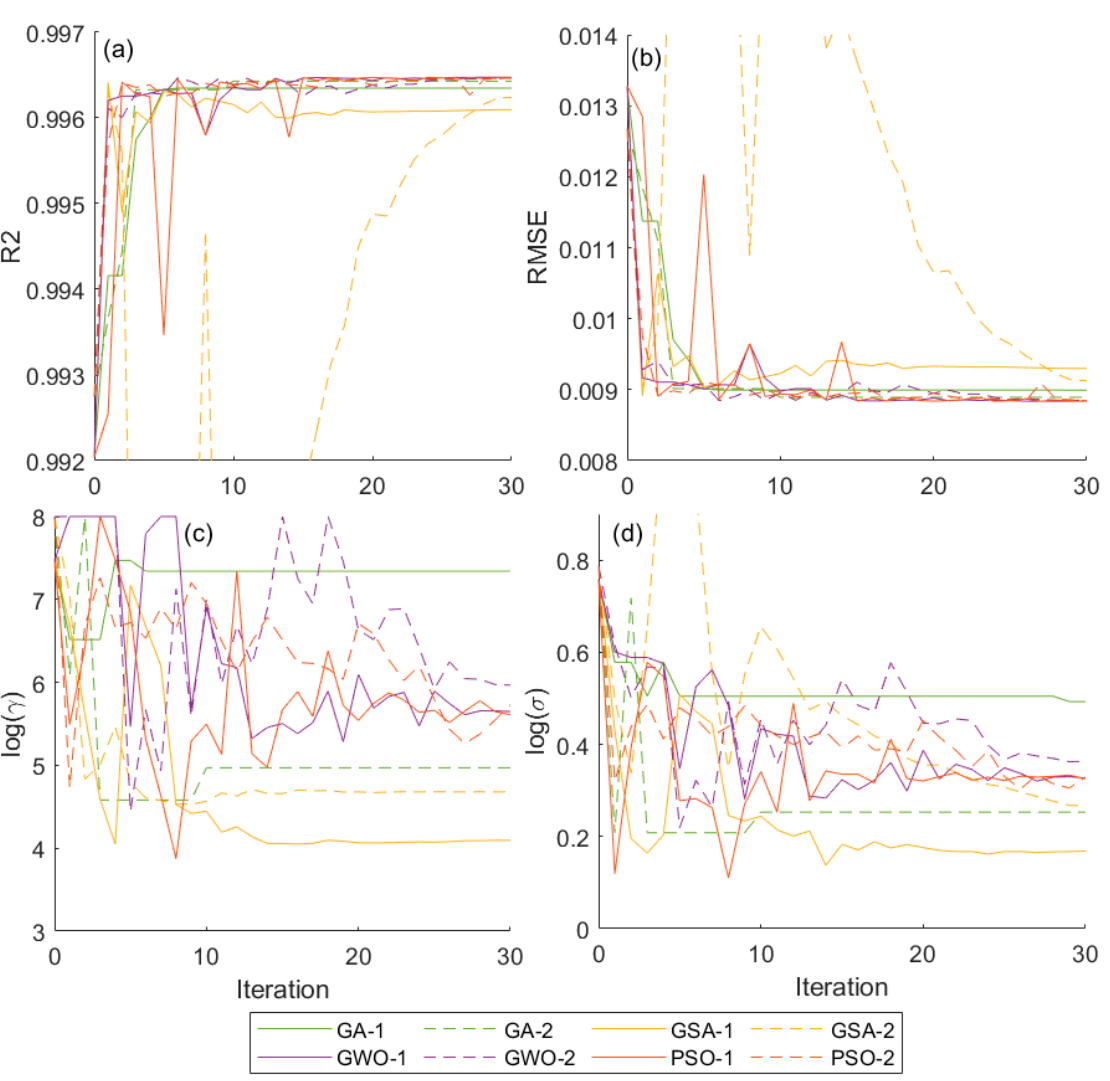
Figure 5. Illustration of optimizer performance in terms of the best solution’s R 2 ( a ), RMSE ( b ) and search parameter values log ( γ ) ( c ) and log ( σ ) ( d ), at a given iteration. In total, 20 solutions were initiated and run for 30 iterations in each case. Two identical initializations (marked 1 and 2) were run for each algorithm.